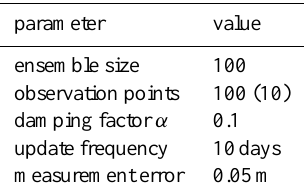
Table 3. Default settings for data assimilation with